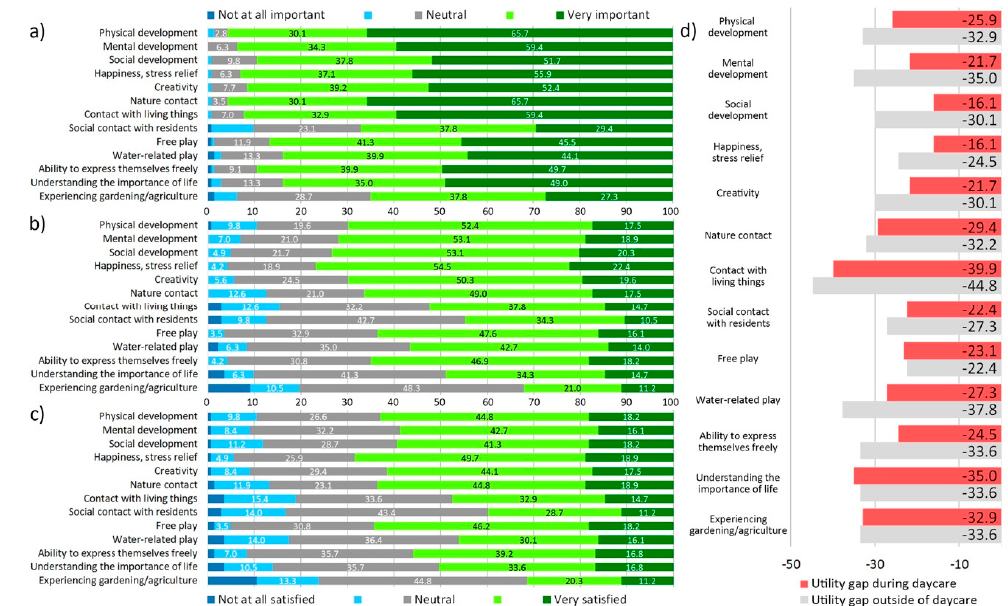
Figure 7. UDC parents perception of GS: ( a ) importance of outdoor play for children aged five or under in regard to…, ( b ) satisfaction with greenspace regularly used during daycare in regard to…, ( c ) satisfaction with greenspace regularly used outside of daycare in regard to…, ( d ) utility gap of greenspace used during and outside of daycare (satisfaction - importance).